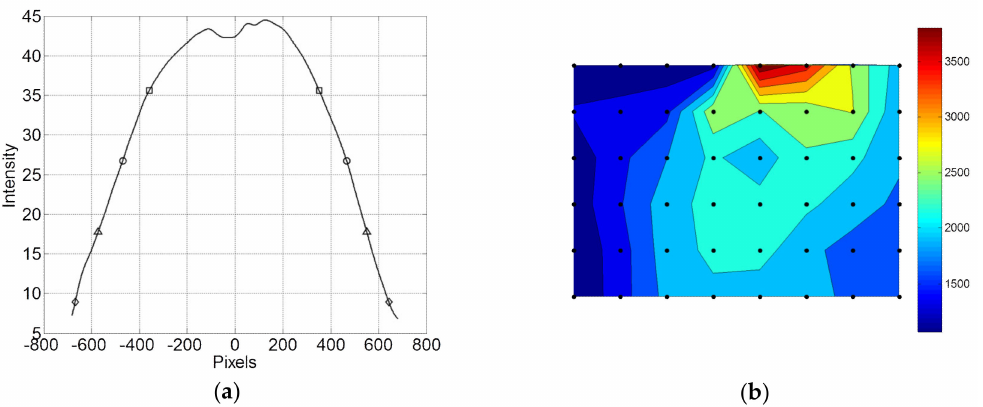
Figure 16. ( a ) Averged intensity profile using two intensity profiles at the diagonal sample lines. The obtained widths for the ratios of 0.2, 0.4, 0.6, and 0.8 are expressed by diamond, square, circle, and triangle marks respectively; ( b ) contour map of the coating uniformity.